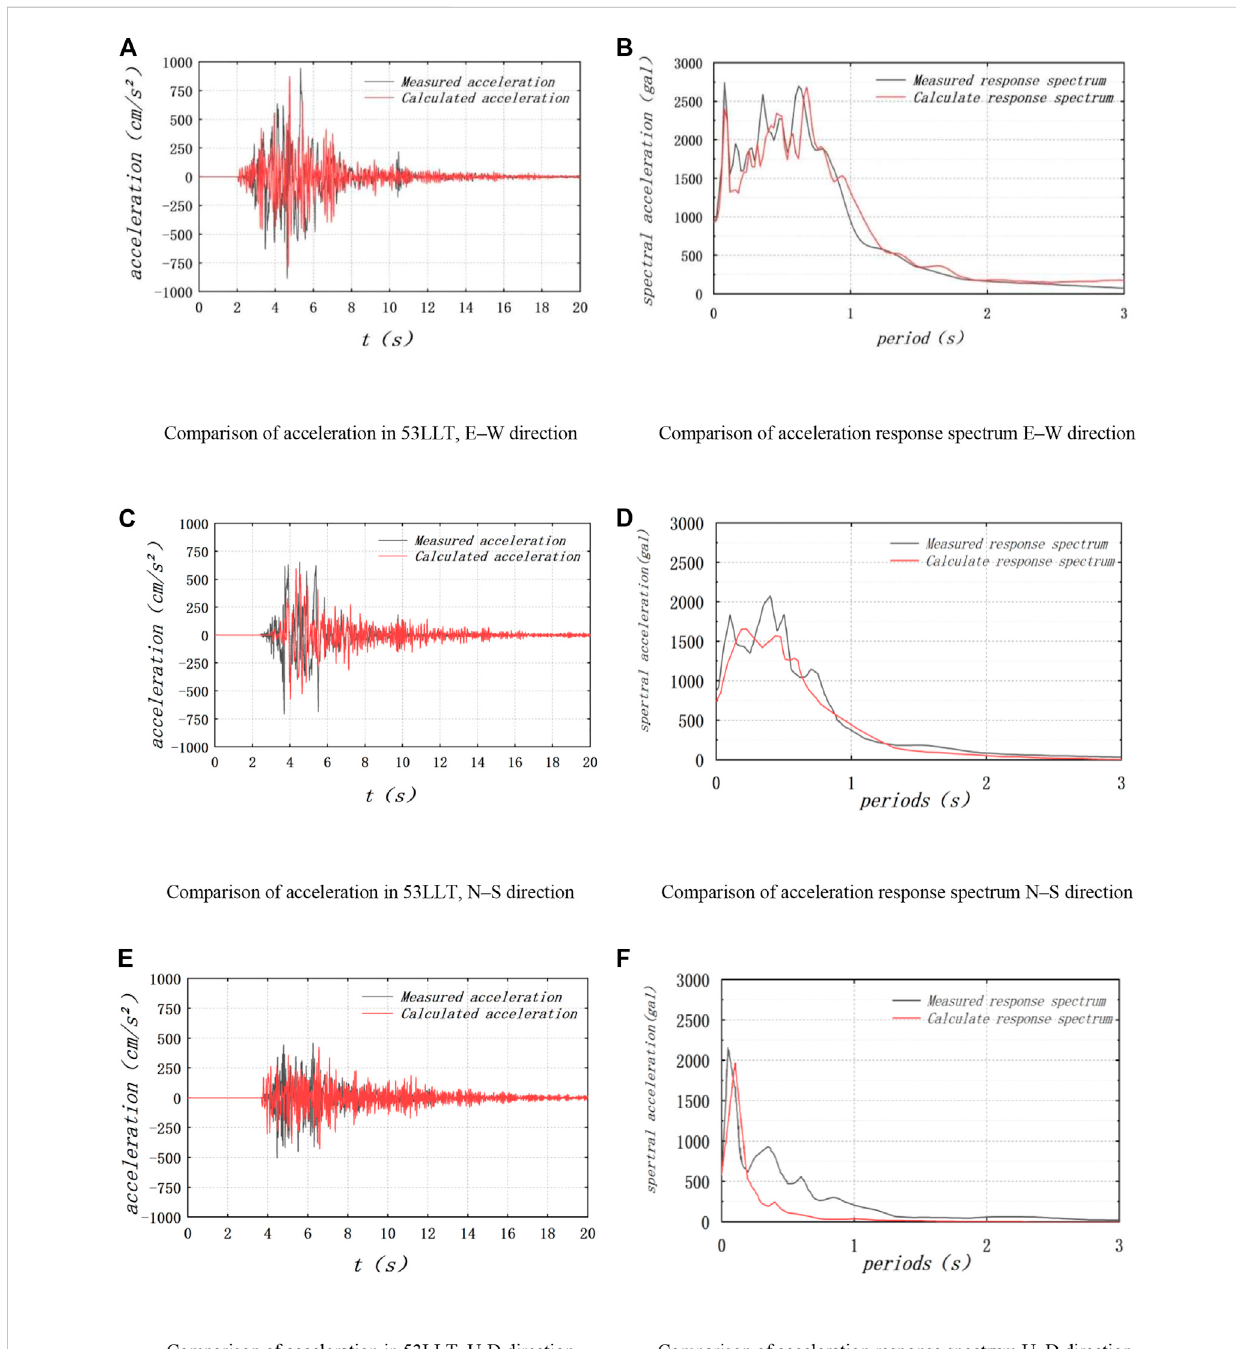
FIGURE 11 Comparisonbetweenthesimulationandobservedrecords. (A) Comparisonofaccelerationin53LLT,E – Wdirection. (B) Comparisonofacceleration response spectrum E – W direction. (C) Comparison of acceleration in 53LLT, N – S direction. (D) Comparison of acceleration response spectrum N – S direction. (E) Comparison of acceleration in 53LLT, U-D direction. (F) Comparison of acceleration response spectrum U – D